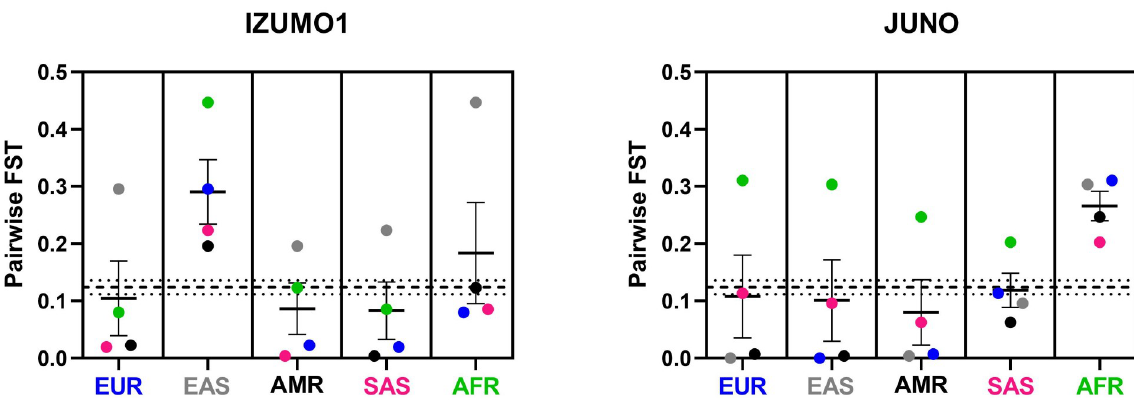
Fig 5. F ST values in the IZUMO1 and JUNO genes for the European (EUR), East Asian (EAS), South Asian (SAS), African (AFR) and American (AMR) population pairs. These F ST values were calculated using SNPs with a MAF of at least 5%. An F ST along the 0.124 (dashed line) plus or minus 2 standard deviations (dotted lines) is considered to be consistent with the rest of the human genome [57]. The average F ST value for each population group relative to all other groups is shown as a solid line. The populations analyzed include AMR (n = 347), AFR (n = 661), EUR (n = 503), EAS (n = 504), and SAS (n = 489), where n indicates the number of individuals in each population